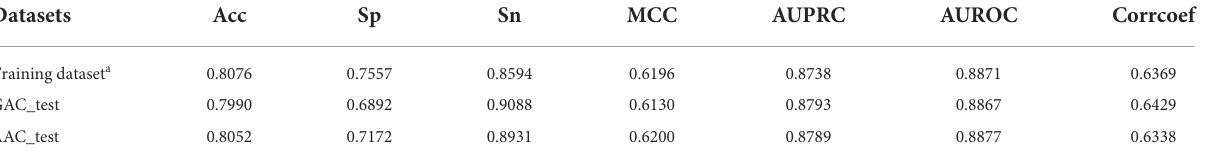
TABLE 5 Performance of the CNN + BiLSTM model built on the combined dataset of GAC_train and AAC_train.